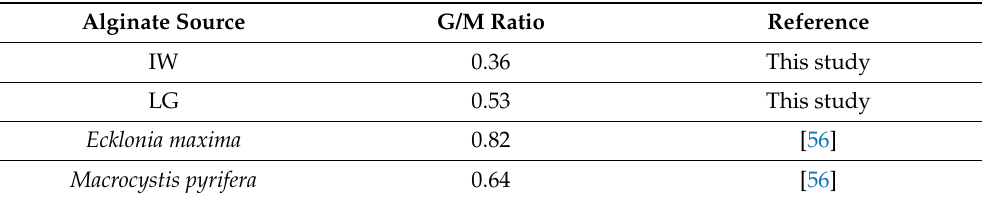
Table 1. Guluronic to mannuronic acid ratio of Ecklonia maxima and Macrocystis pyrifera from literature [56] and the G/M ratio results of laboratory-grade alginate (LG) and alginate sourced from industrial kelp solid waste (IW).